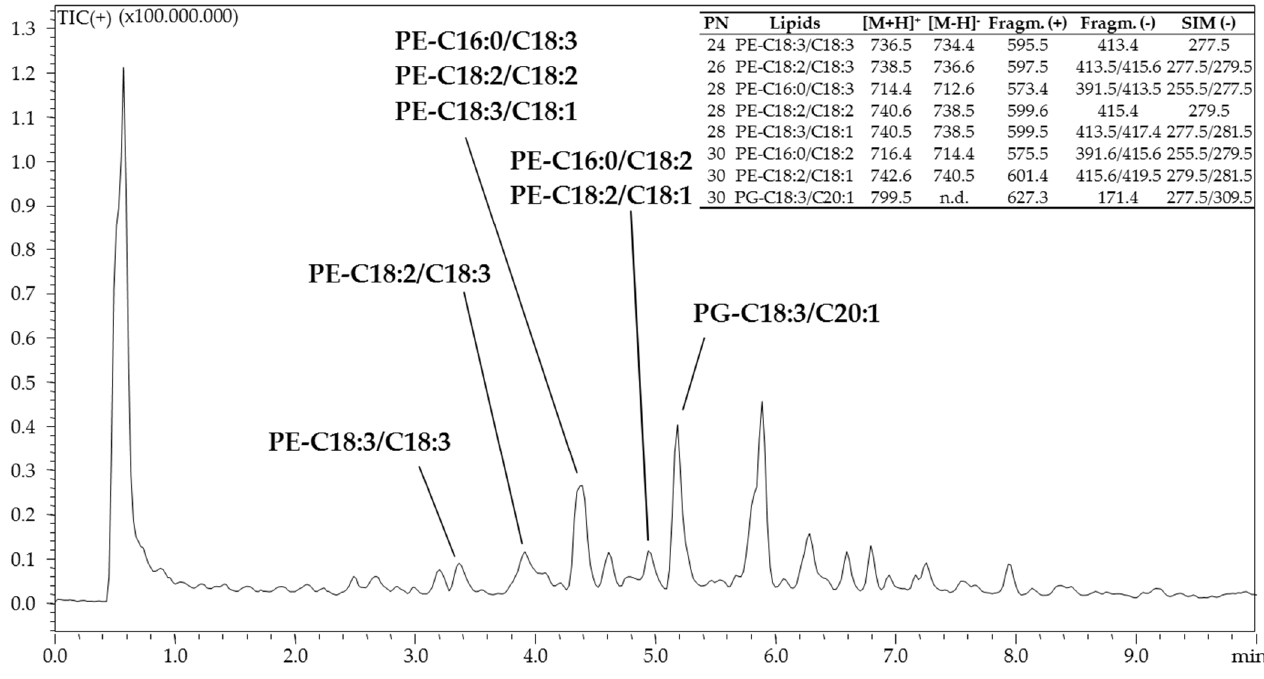
Figure 3. RP-UHPLC-APCI (+) -qMS analysis of phospholipids in Chia seed oil.